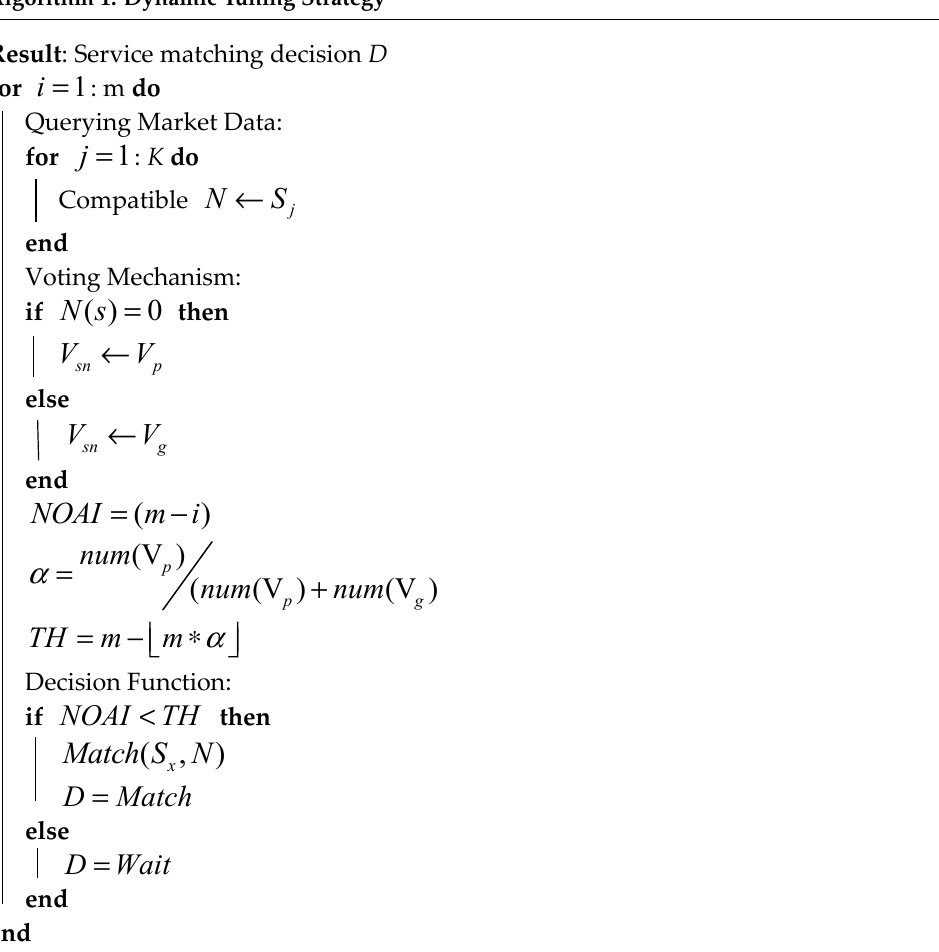
Algorithm 1: Dynamic Tuning Strategy